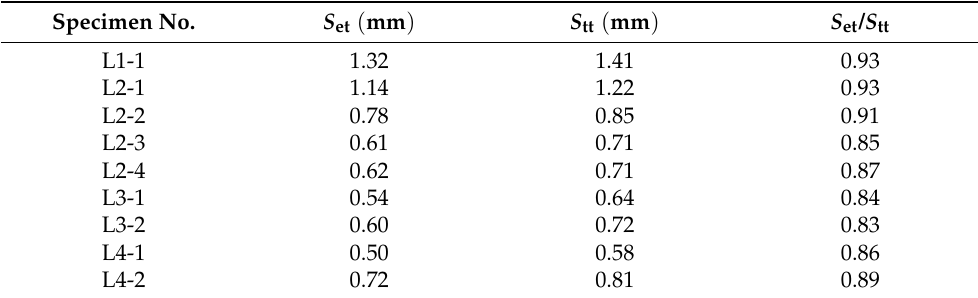
The theoretical and experimental values of relative slip of elastic limit theory of composite beams. Specimen